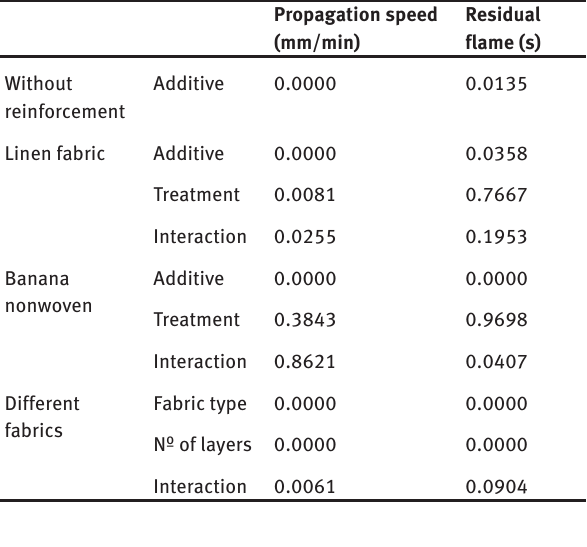
Table 3: P-value in the ANOVA analysis of fire properties.